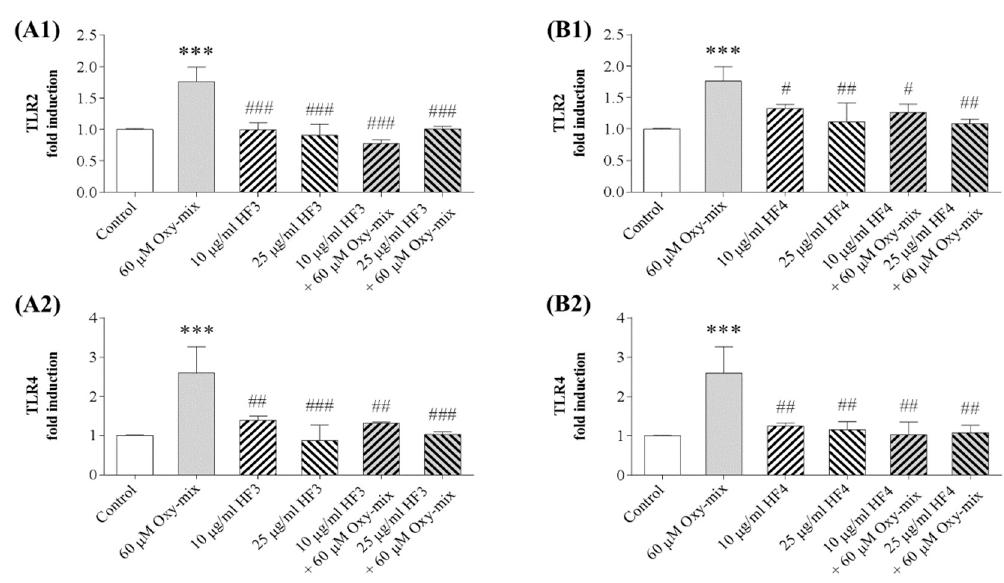
Figure 5. HF3 and HF4 prevent TLR2 and TLR4 induction by dietary oxysterols in di ff erentiated CaCo-2 cells. HF3 (Panel A): TLR2 ( A1 ), TLR4 ( A2 ); HF4 (Panel B): TLR2 ( B1 ), TLR4 ( B2 ). Cells were pre-treated or not with 10 or 25 µ g / mL of HF3 or HF4 for 1 h. Cells were then treated with 60 µ M Oxy-mix for 24 h. TLR2 and TLR4 expression was evaluated by using RT-PCR. CBS extract pre-treatment significantly prevented the gene expression induction of both TLR2 and TLR4. Data are reported as means ± SD of three experiments performed in triplicate. One-way analysis of variance (ANOVA) associated with Bonferroni’s multiple comparison post-test was adopted: significantly di ff erent vs. controls: *** p < 0.001; significantly di ff erent vs. Oxy-mix: # p < 0.05, ## p < 0.01 and ### p < 0.001.